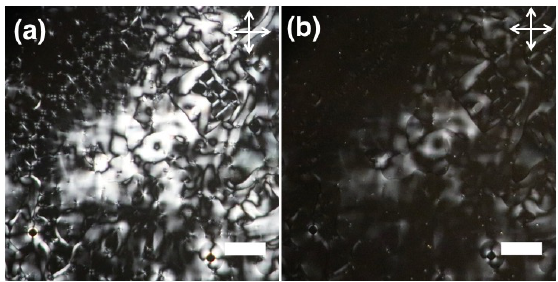
Figure 11. POM image of LCE film polymerized at 55 ◦ C between untreated glass slide and cover slip (crossed polarizers): ( a ) At 20 ◦ C and ( b ) At 115.8 ◦ C at isotropic phase. (scale: 200 µ